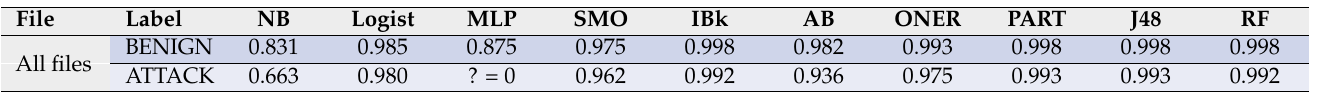
Table 19. F1 performance results using Zeek derived flows and attributes in the complete